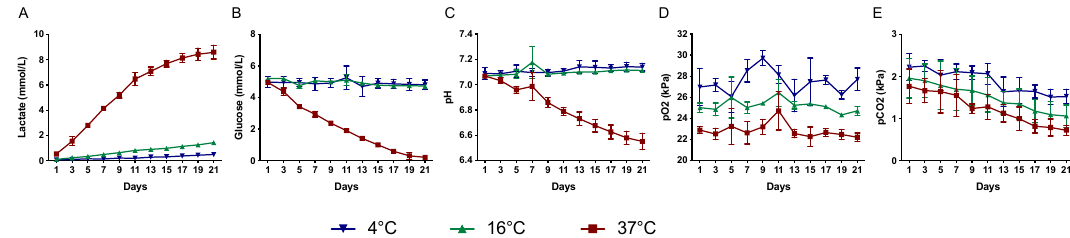
Figure 1. Effect of storage temperature on the metabolic function of RPE cells. The level of lactate ( A ), glucose ( B ), pH ( C ), pO 2 ( D ), and pCO 2 ( E ) in the storage medium was measured every alternate day during the storage period. Data are presented as mean ± standard deviation of the mean. ( n = 8).